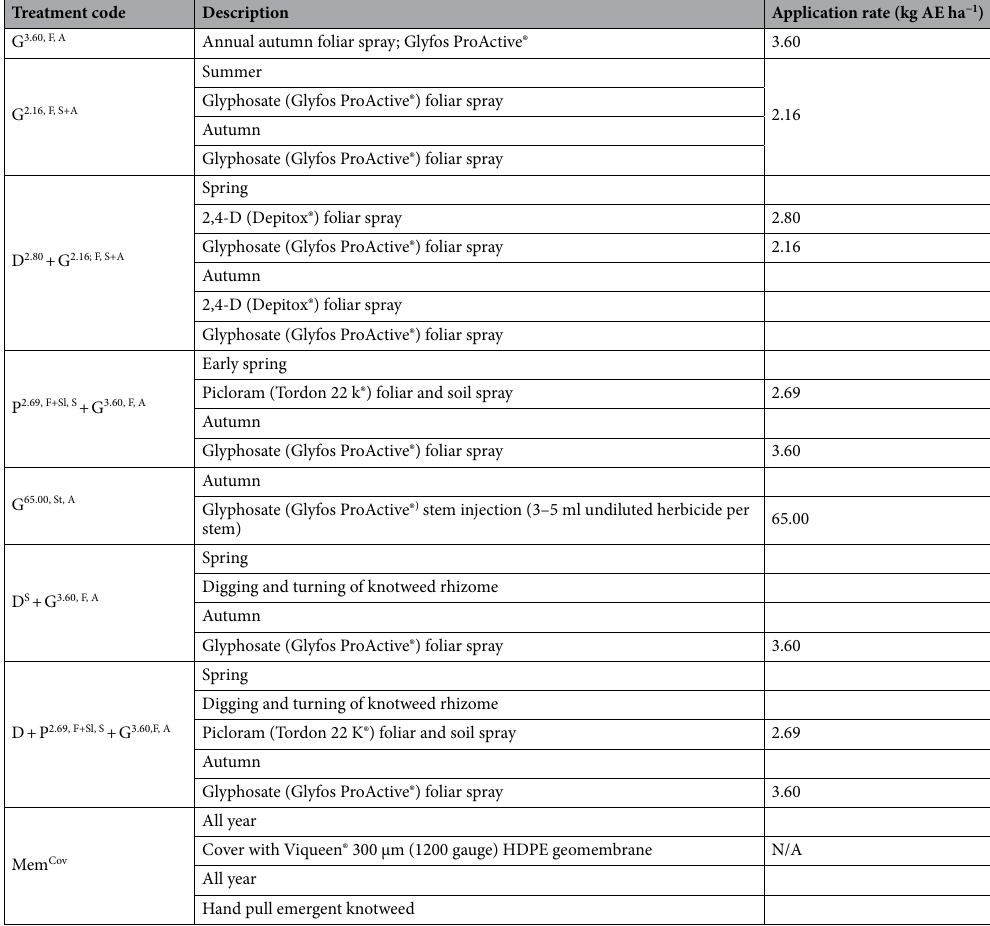
Table 1. Japanese knotweed control treatment groups of interest for LCA (Adapted from Jones, 2015 and Jones et al. 23 ). Treatment codes refer to the herbicide active ingredient (G = glyphosate, D = 2,4-D, P = picloram), application rate, application method (F = foliar spray, Sl = soil spray, St = stem injection, Cov = covering), and time of year applied (S = spring, A = autumn). Specific timing of seasonal application: spring = April-June; autumn =